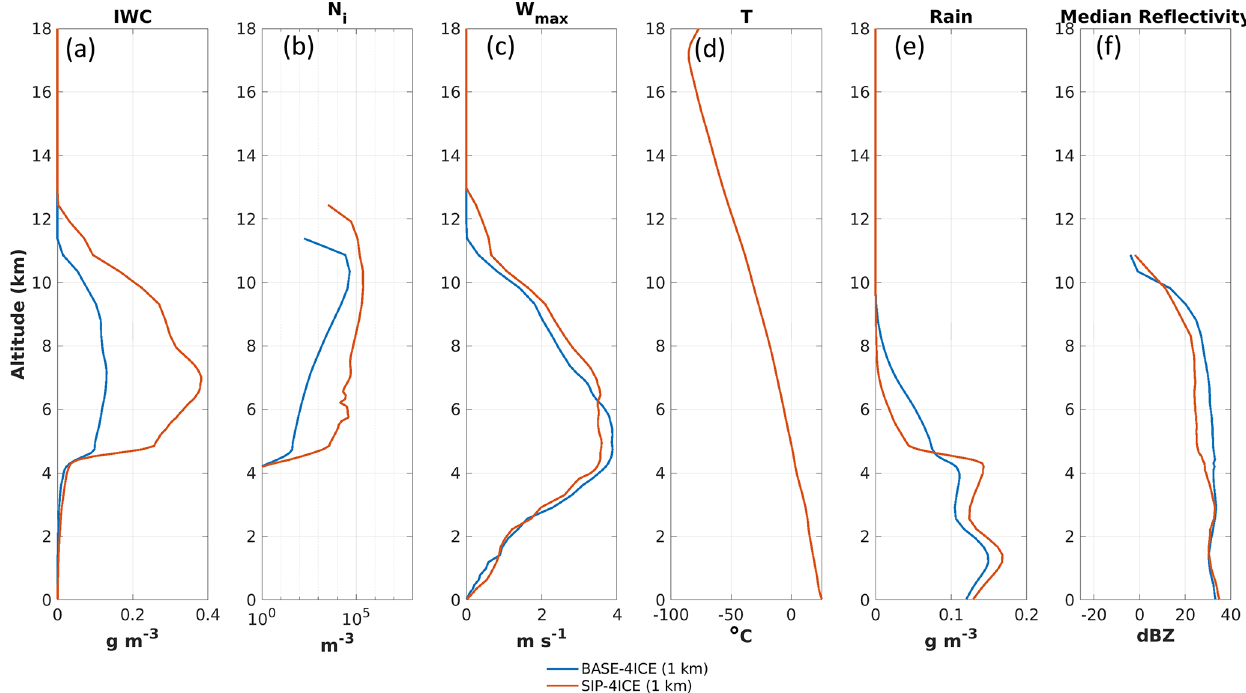
Figure 22. Similar to Fig. 6 but for simulation at a 1km horizontal grid spacing.